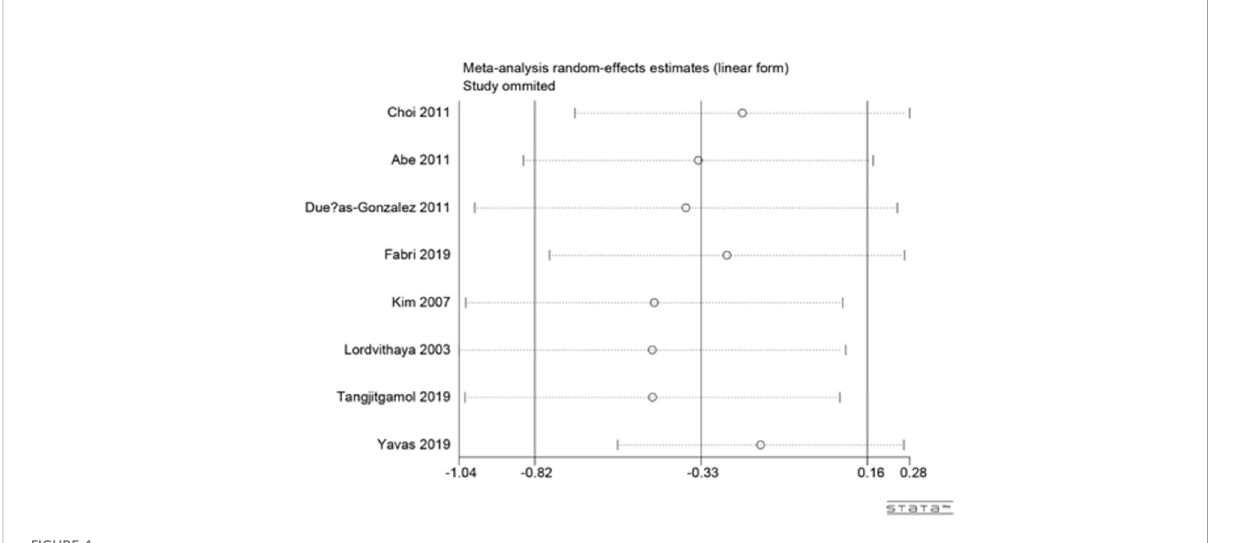
FIGURE 4 Sensitivity analysis of the 3-year rates of OS.